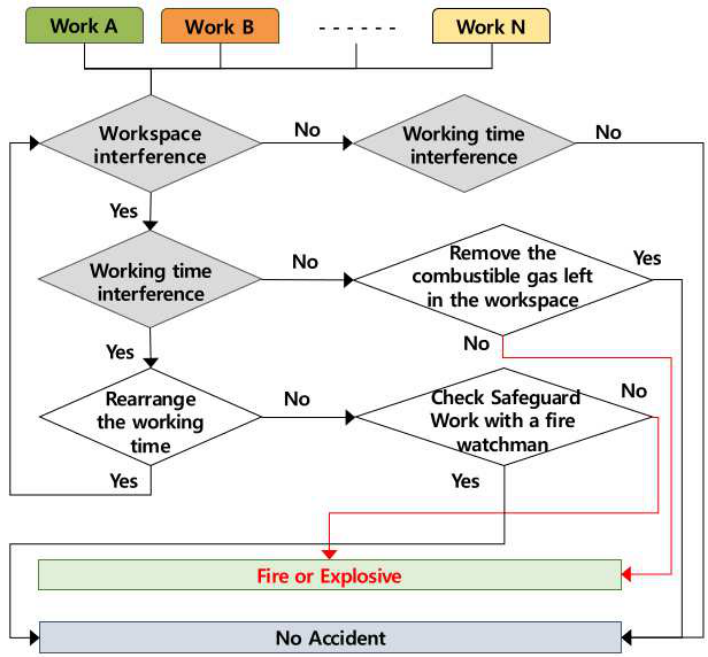
Figure 4. Mechanism of fire and explosion caused by multiple processes in the workplace (AMMP model—fire and explosion).